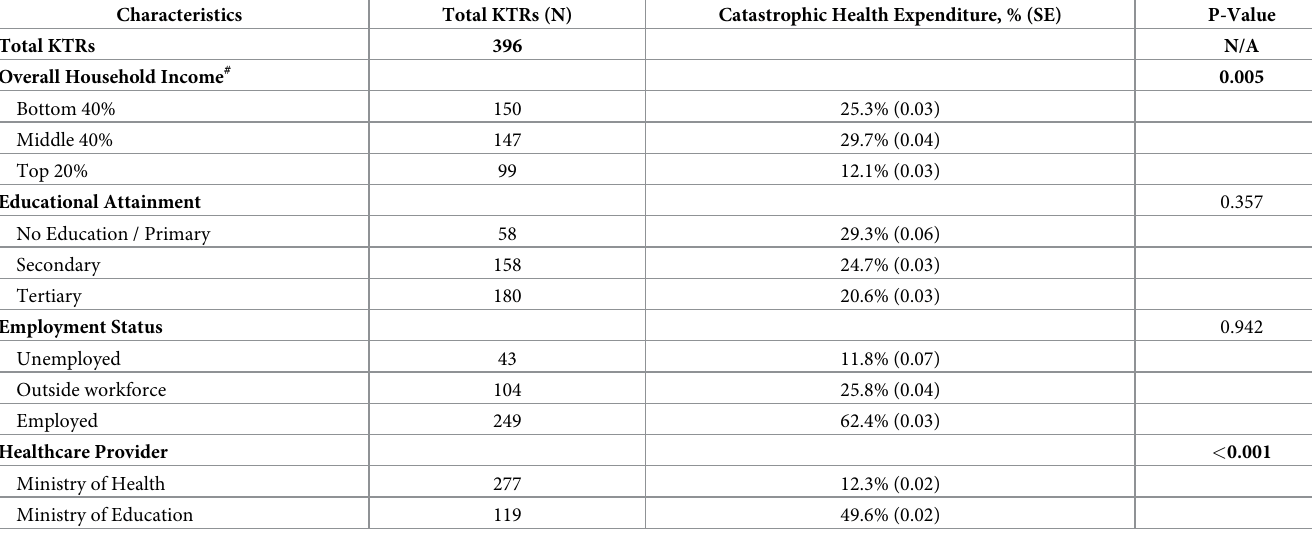
Table 3. Prevalence of catastrophic health expenditure by levels of socioeconomic status and healthcare provider.